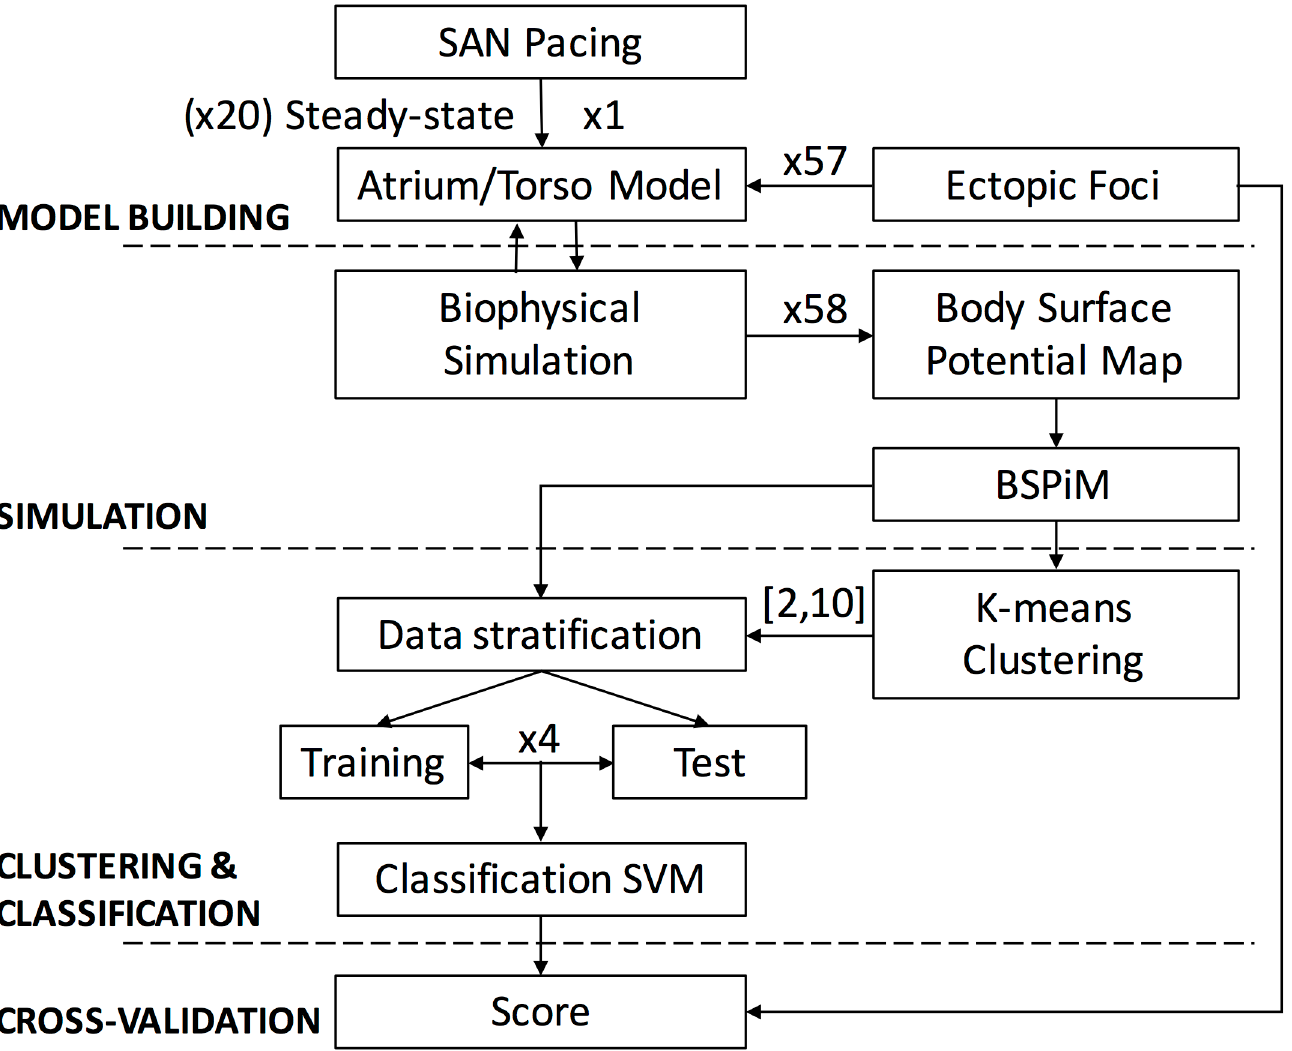
Fig 3. Methodological pipeline. The atrial-torsomodel was built up and stabilizedin sinus rhythm. Afterwards, 57 new biophysicalsimulations were carried out stimulatingat 57 additionalectopic foci in order to compute the corresponding BSPMs and BSPiMs. Machinelearningtechniqueswere used to firstly cluster these ectopic sites into spatialand well-definedatrial regions and to secondlybe able to prospectively classify and predict the origin of new sites with high accuracy.